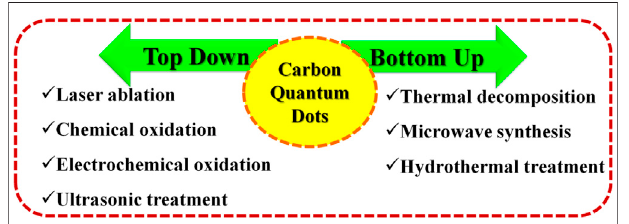
FIGURE2| SchematicrepresentationofCQDssynthesisby “ top-down ” and “ bottom-up ” approaches.